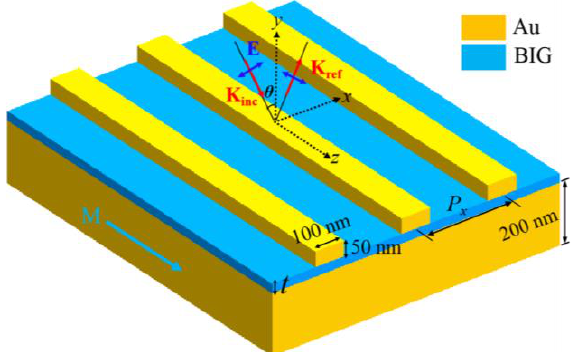
Figure 1. Schematic of metasurfaces for the TMOKE enhancement of ultra-thin BIG films. Au nanowires are infinite along the z direction and periodically arranged along x direction, which have a cross section of 100 × 50 nm. The ultra-thin BIG magnetic film has a thickness of t . The illumination source is p-polarized and propagates in the x - y plane. The external magnetization vector, M, is parallel to the z axis.